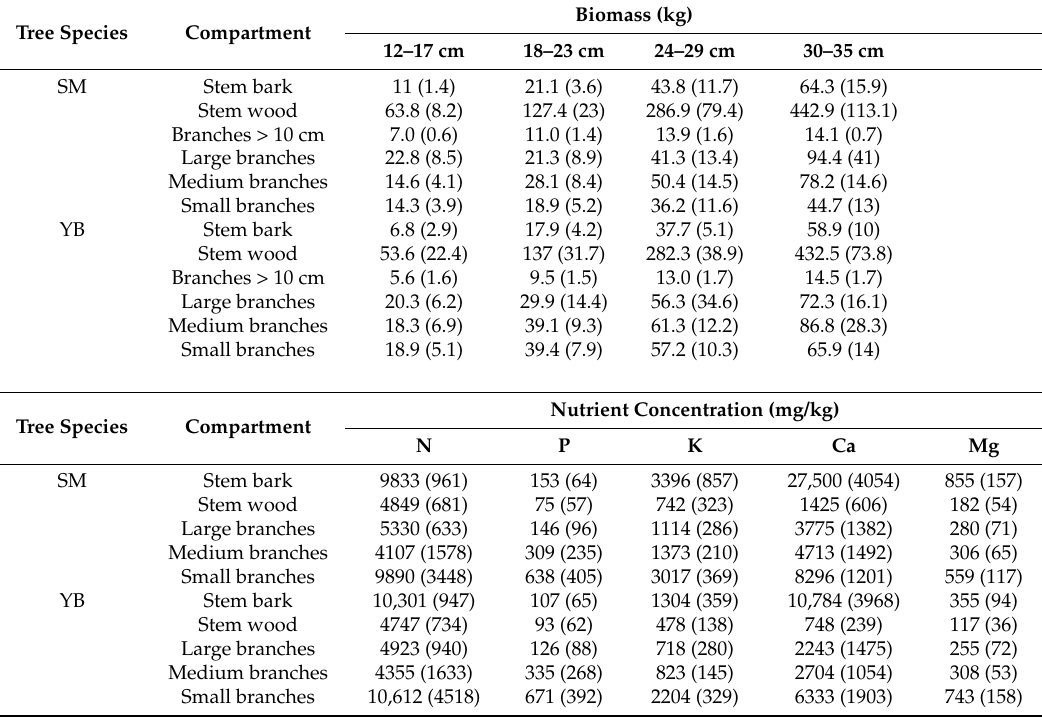
Table 1. Biomass estimates and measured nutrient concentrations for each branch and stem compartment that was defined in this study. Biomass values are presented per DBH (diameter at breast height, 1.3 m) class. The stem compartment was separated into stem bark and stem wood. For further analysis and interpretation, branches with a diameter larger than 10 cm were included in the stem compartment. Values in parentheses are standard deviation. SM = sugar maple, YB = yellow